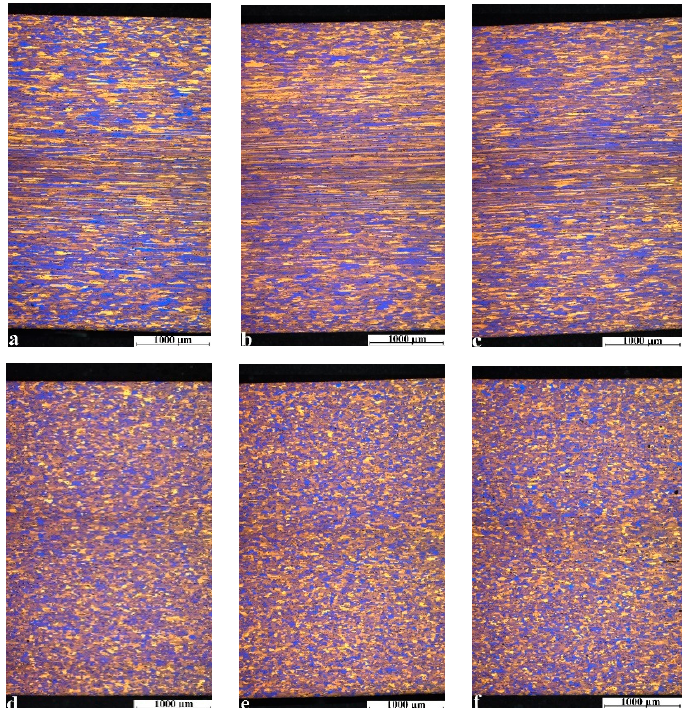
Figure 4. Microstructure in samples’ cross-sections for symmetrically rolled 1.0 ( a ), asymmetrically rolled 1.5 ( b ), asymmetrically rolled 2.0 ( c ), symmetrically rolled 1.0 and heat treated ( d ), asymmetrically rolled 1. 5 and heat treated ( e ) and asymmetrically rolled 2.0 and heat treated ( f ).